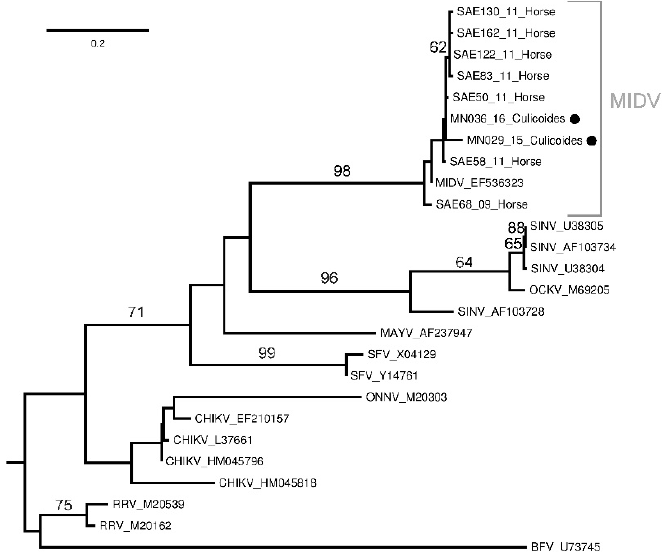
Figure 3 . Maximum likelihood phylogram of the partial (nucleotides = 198, 26 taxa) Alphavirus NsP4 gene region. Bootstrap support calculated using autoMRE function invoked in RAxML (GTR + G model). Barmah Forest (BFV) and Ross River virus (RRV) were used as outgroups. Filled black circles indicate new sequences.